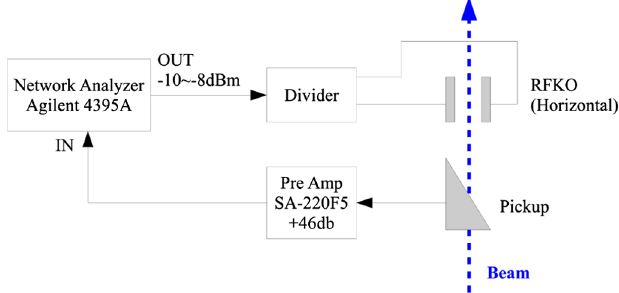
FIG. 2. Conceptual diagram of tune measurement.